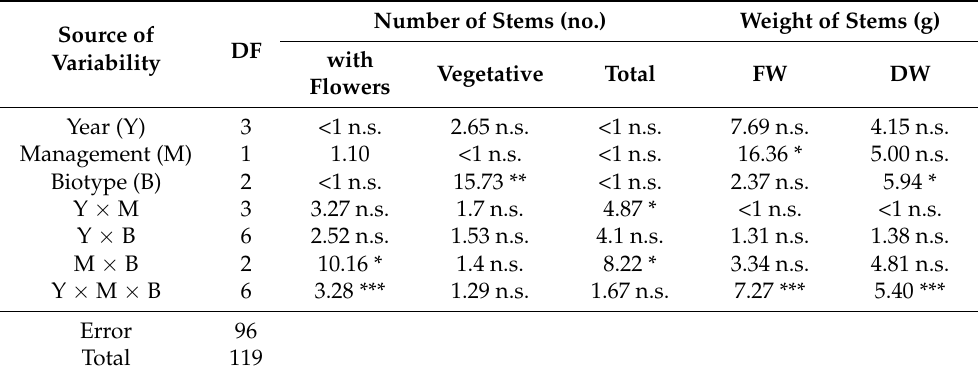
Figure 1. Height (cm) at flowering time of 3 H. perforatum biotypes cultivated from 2014 to 2016 with two management systems. Mean values by biotype (AG—Agrigento, SI—Siena, and TN—Trento) and plant management (P—pots and F—open field) across cultivation years. Error bars indicate standard deviation. Symbols above each group refer to the significance at ANOVA (***: p ≤ 0.001; n.s.: not significant). Table 2. Results of ANOVA ( F values) for the number and the fresh (FW) and dry (DW) weight of stems per plant in 3 H. perforatum biotypes cultivated from 2014 to 2016 with two management systems.